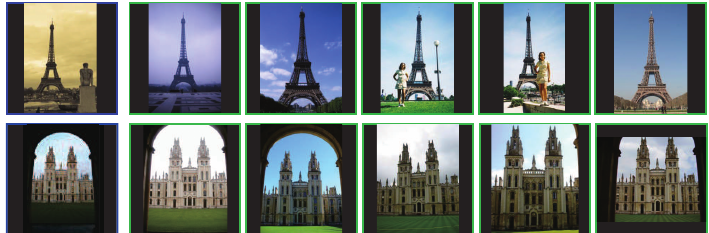
Figure 8. Examples of the proposed image retrieval method. The first column is the query image with blue contour, and the others with green contour are retrieved